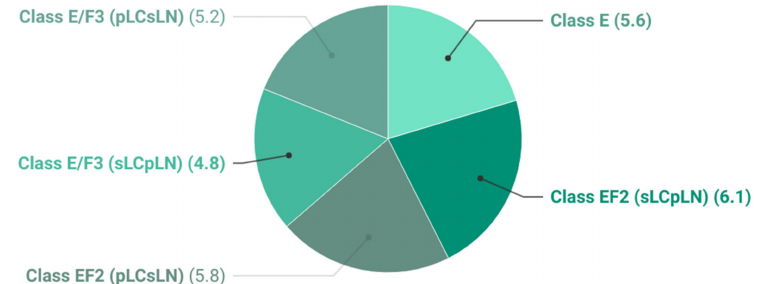
Figure 12. The THD v of class E and enhanced class E inverters at optimum